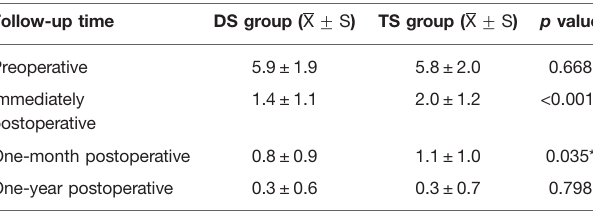
TABLE 2. | Comparison of VAS for back pain between DS group and TS group.